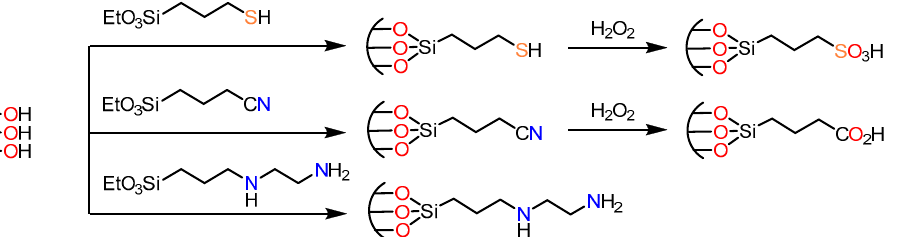
Figure 14 . MCM-41 functionalization.